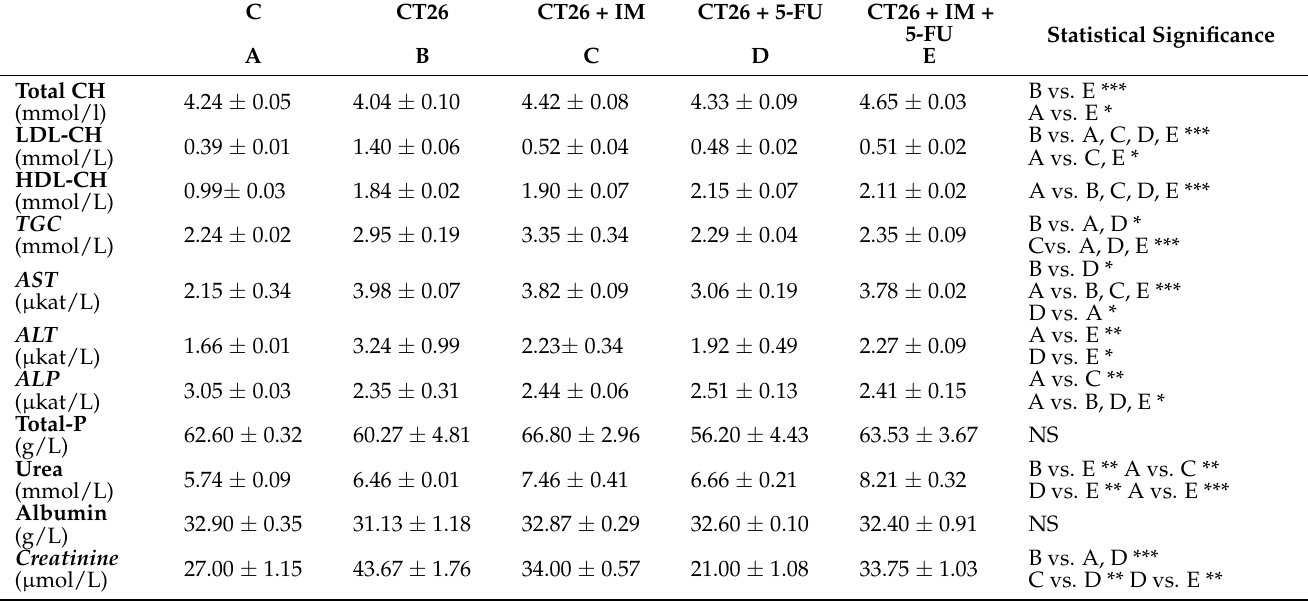
Table 2. The effect of treatments on biochemical parameters in mouse serum samples.